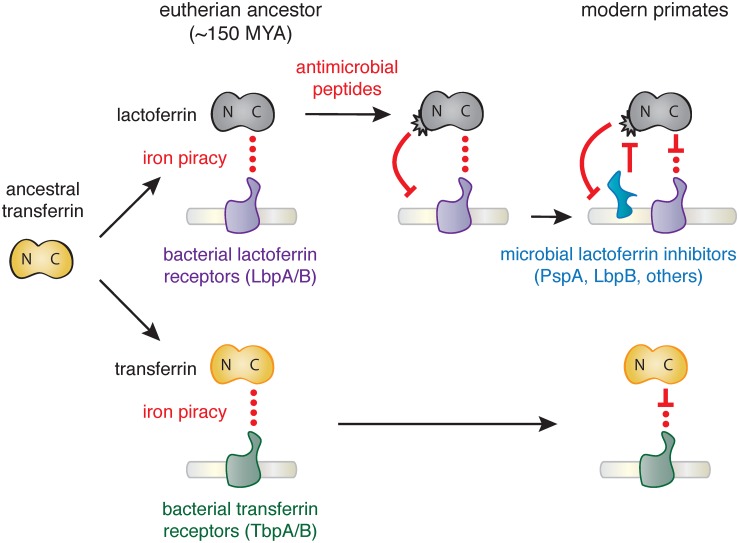
Model of lactoferrin evolution and genetic conflicts with pathogens.Following a duplication of the transferrin gene in the ancestor of eutherian mammals, interactions between the transferrin (yellow) C lobe and the bacterial transferrin receptors such as TbpA (green) led to the emergence of a molecular arms race. In contrast, while lactoferrin has likely also been engaged in evolutionary conflicts with pathogen iron acquisition receptors like LbpA (purple), the emergence of antimicrobial peptide activity in the N lobe would have provided novel defense activity against pathogens targeting lactoferrin as an iron source. This function would have led to the emergence of pathogen inhibitors of lactoferrin antimicrobial peptide activity (such as PspA or LbpB), which have dominated subsequent evolutionary conflicts localized to the lactoferrin N lobe.